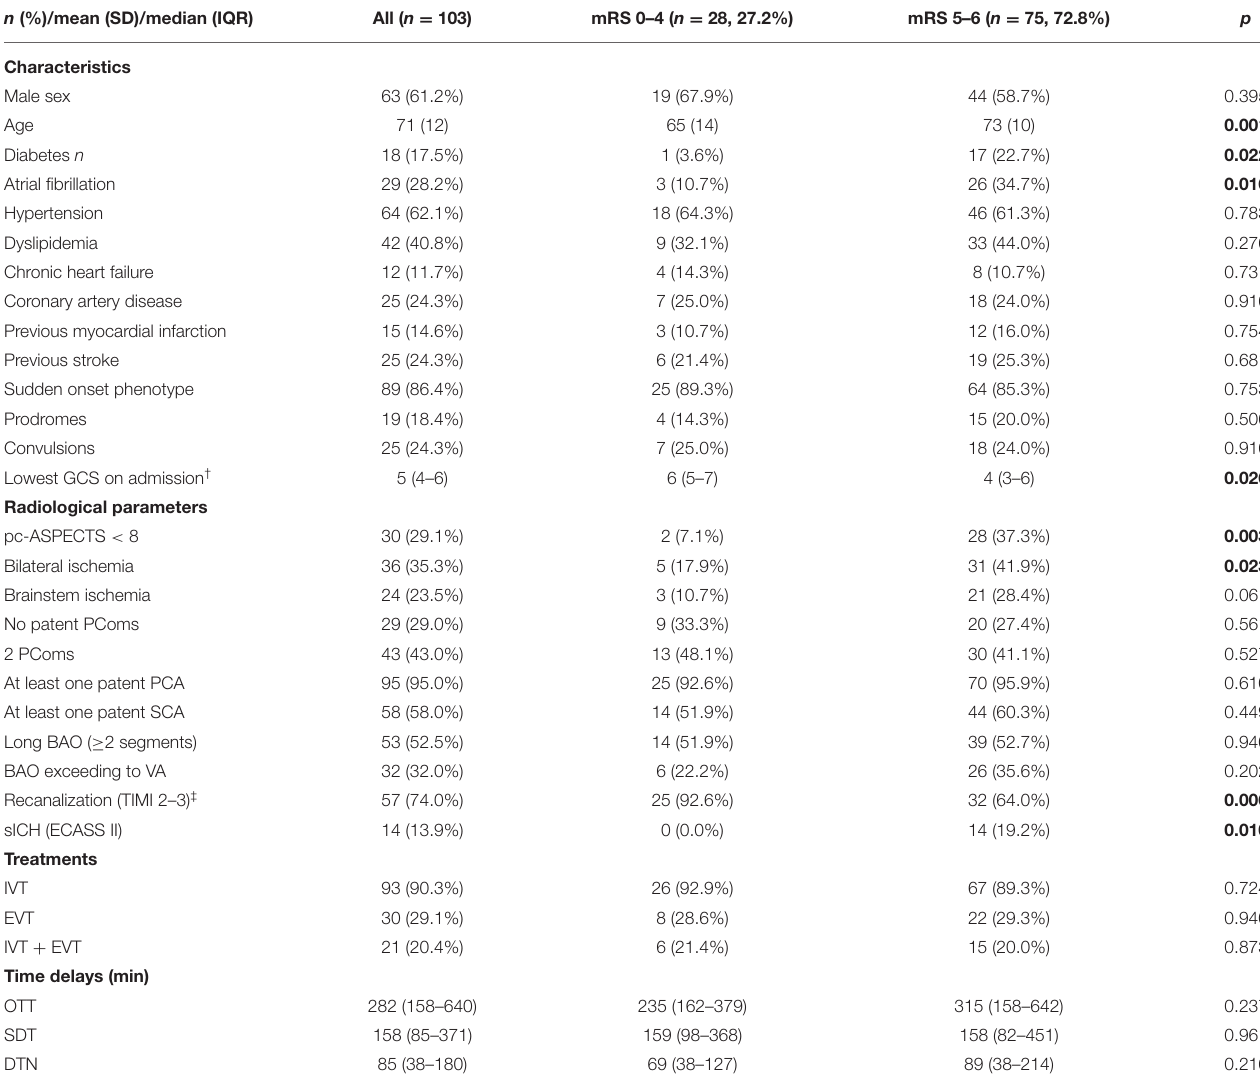
TABLE 5 | Factors associated with poorest outcome (mRS 5–6) in comatose BAO patients. n (%)/mean (SD)/median